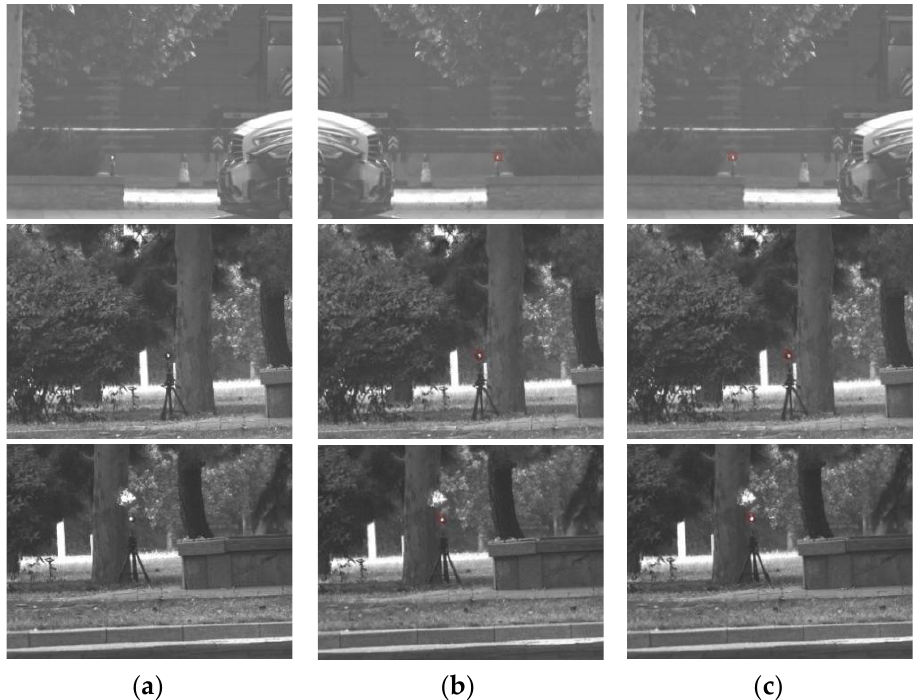
Figure 12. Forward reasoning comparison test: ( a ) active image, ( b ) inference result of ShuffNet, ( c ) inference result of ShuffEng.